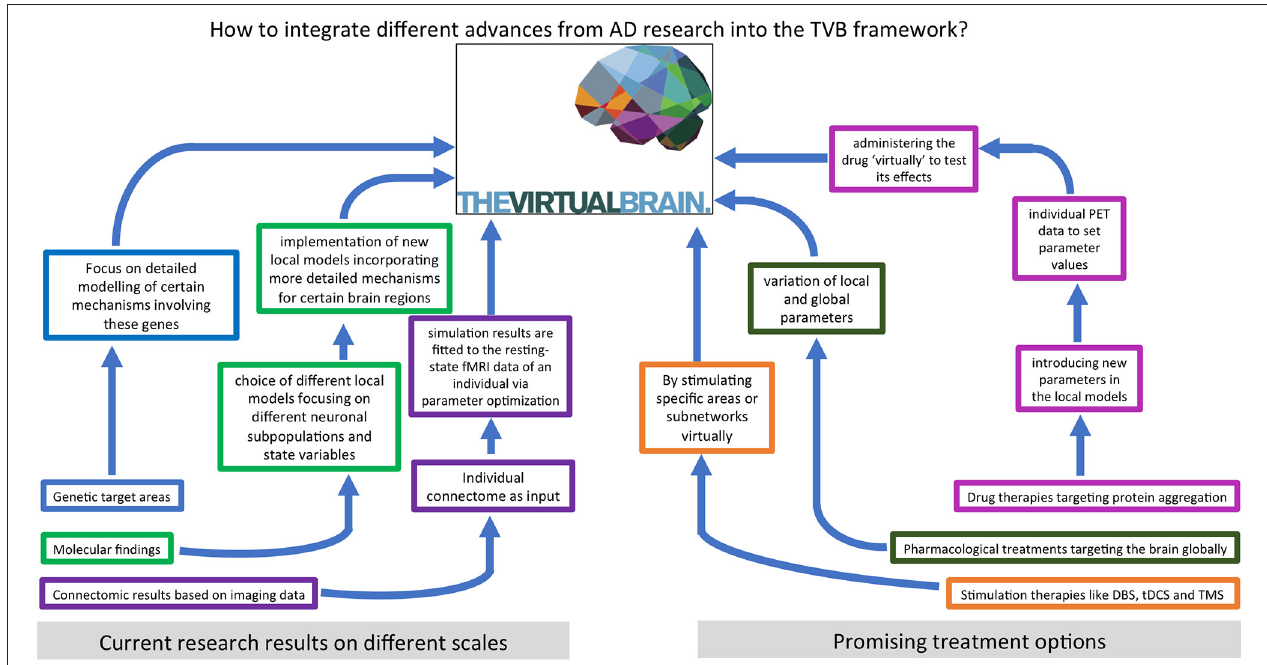
FIGURE 7 | Potential applications of The Virtual Brain in the investigation of Alzheimer’s Disease (AD). As we outline in this article, computational modeling provides a powerful tool to link empirical findings from different scales and disciplines to new insights for improved diagnostics and treatments. PET, positron emission tomography; DBS, deep brain stimulation; tDCS, transcranial direct current stimulation; TMS, transcranial magnetic stimulation.